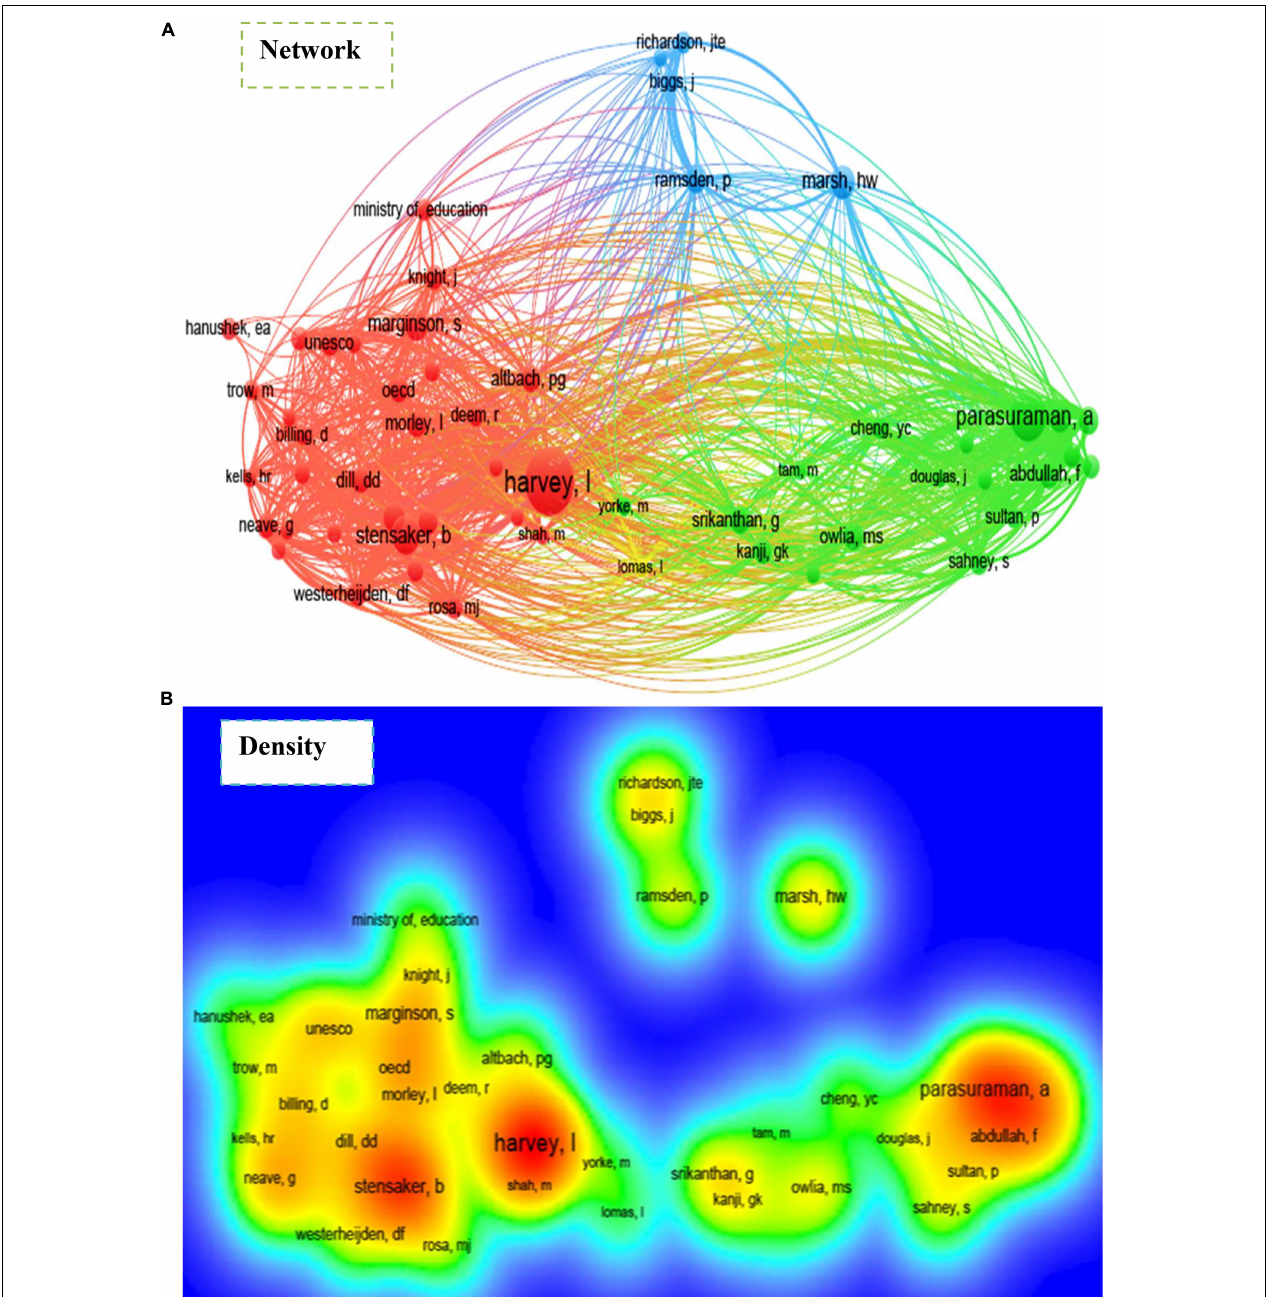
FIGURE 2 | (A) The network of the most cited authors in the quality of higher education. (B) The density of the most cited authors in the quality of higher